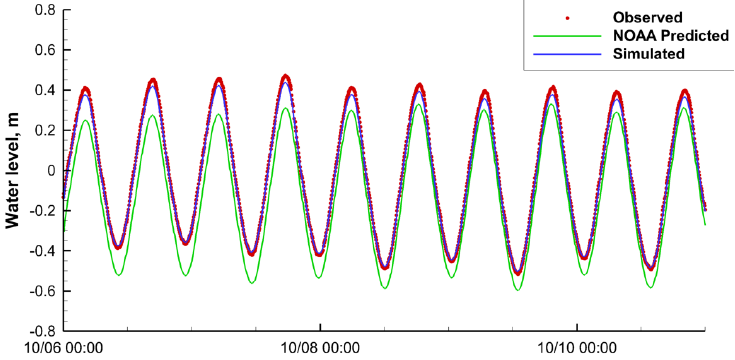
Figure 8. Forecast of “king” tides and comparison with National Oceanic and Atmospheric Administration (NOAA) observed and predicted water levels at Virginia Key station in October 2014 (initialization time: 6 October, 2014 00:00Z).